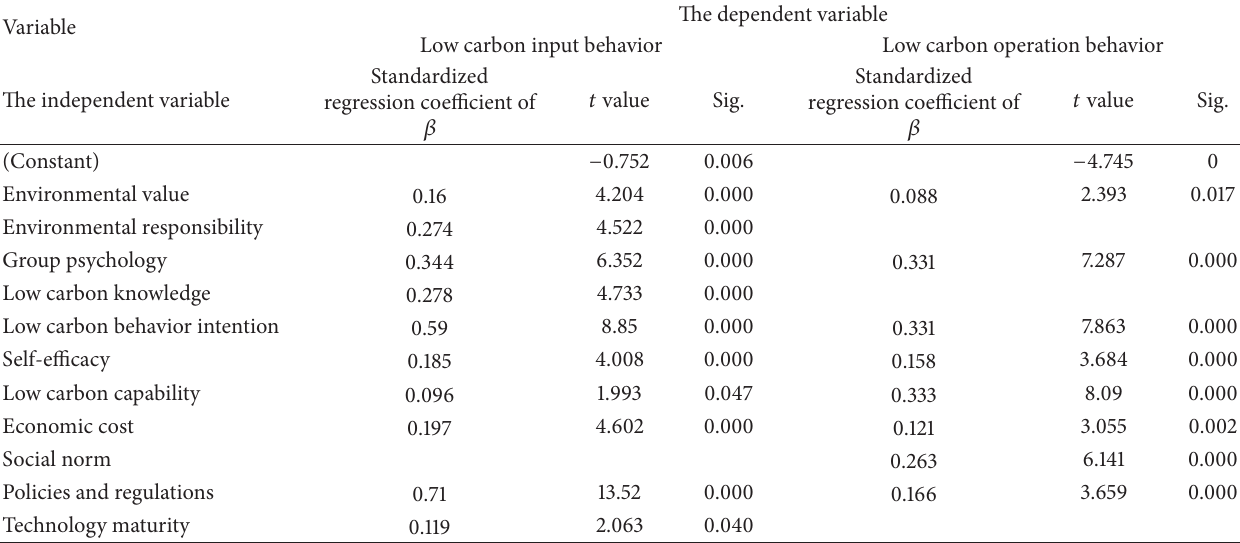
Table 3: The regression analysis within low-carbon investment and operation as the dependent